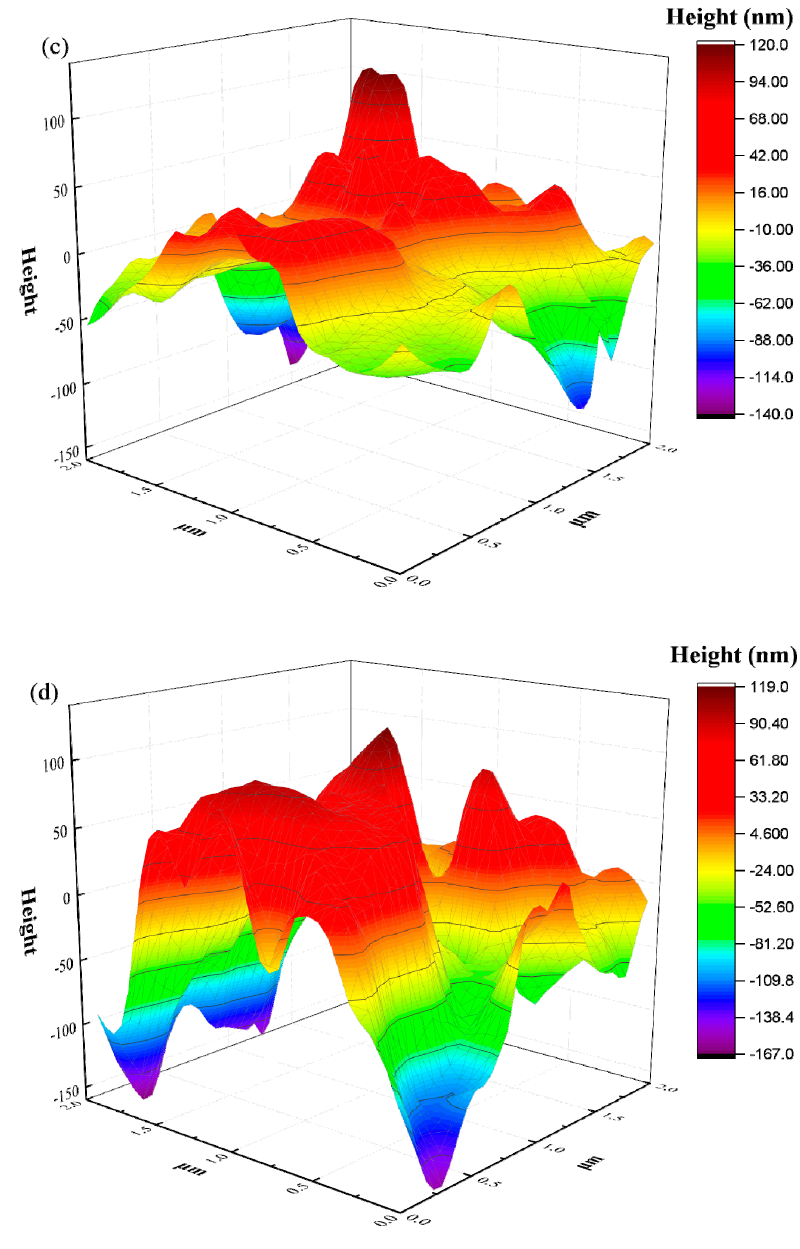
Figure 3. Surface morphology detected by Atomic-force microscopy (AFM) for fluorocarbon (FC) coating with thickness of 0 nm ( a ); 11.3 nm ( b ); 67.8 nm ( c ); and 113 nm ( d ).